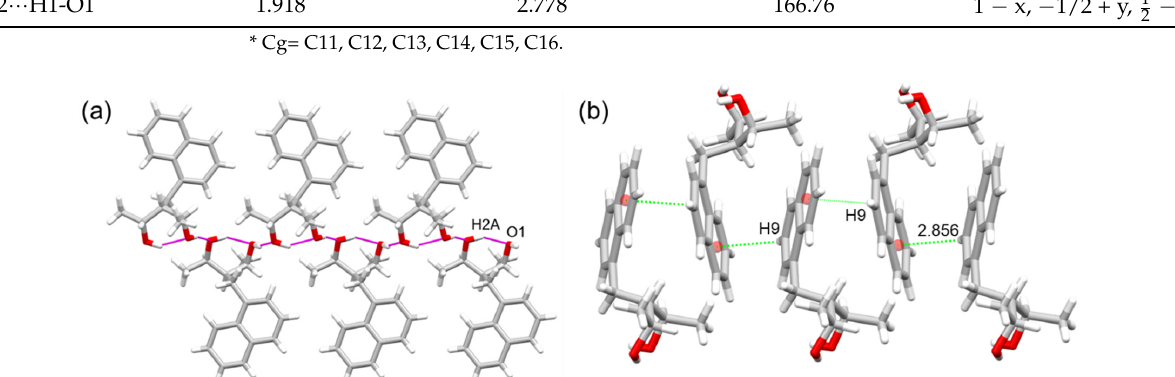
Figure 3. Intermolecular interactions of compound 4a ; ( a ) presence of OH··· and ( b ) CH··· π -type in- teractions.